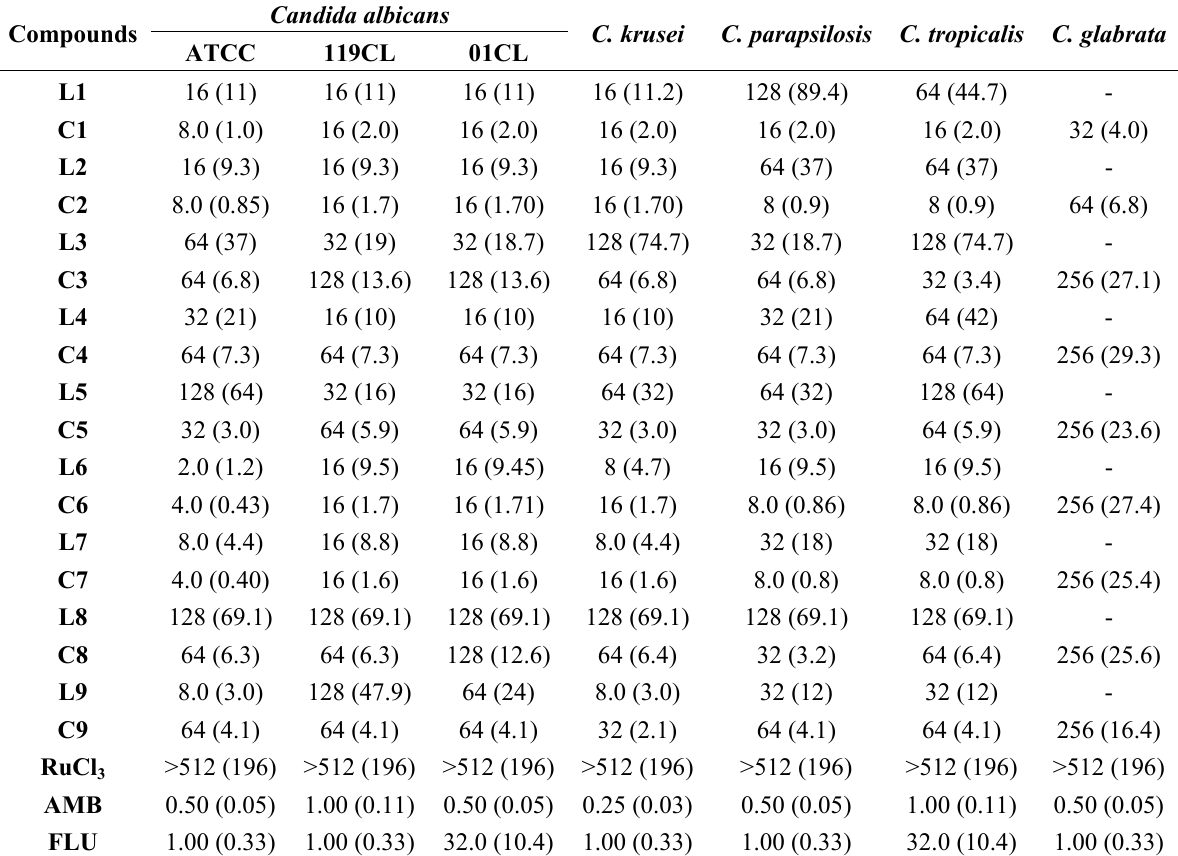
Table 1. In vitro antifungal activity of pentakis-dithiocarbamate diruthenium complexes and the corresponding free ligands (MIC, μ g mL − 1 /10 − 5 mol L − 1 ) against different species of Candida by microdilution